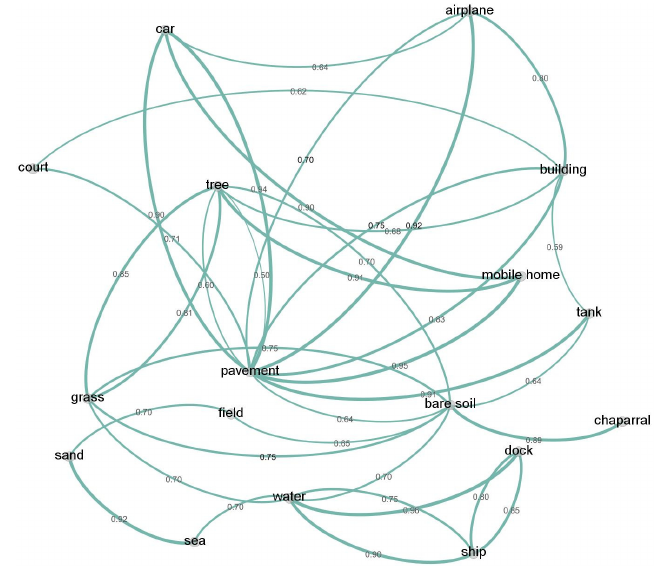
Figure 1. The built label graph on UC-Merced [16,17]